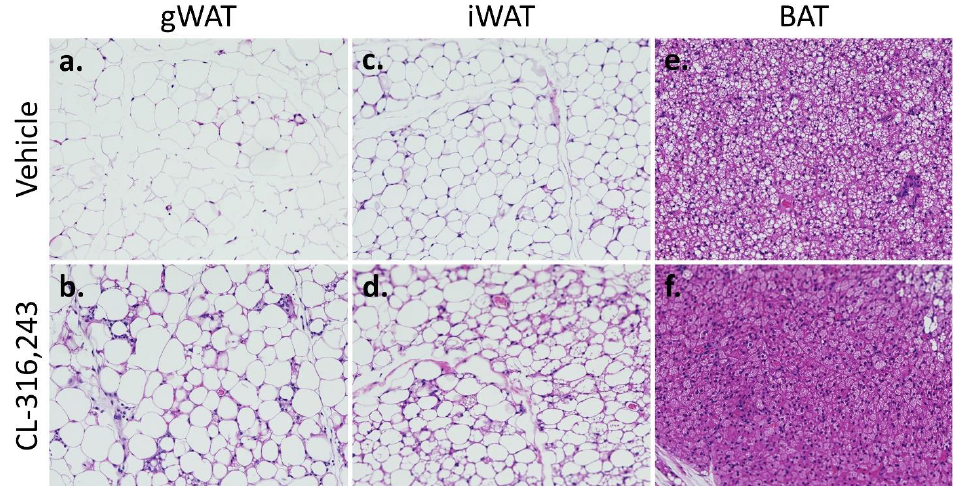
Figure 4. Histology demonstrates increased brown phenotype in mice treated with CL-316,243. 20 × Representative H&E stained sections from control ( a ) and treated ( b ) gWAT, control ( c ) and treated